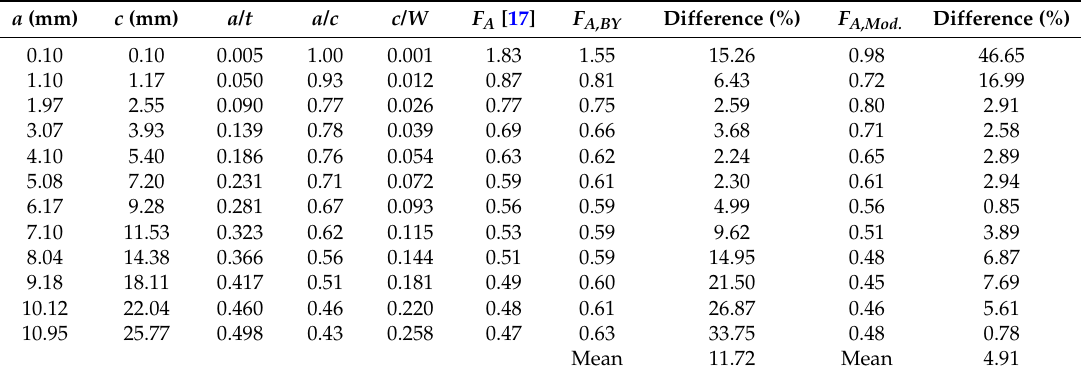
Table 3. Comparison of the dimensionless stress intensity factor values from the Baik-Yamada formula, the modified formula and the literature results by the wavelet and extended finite elememt method at point A .